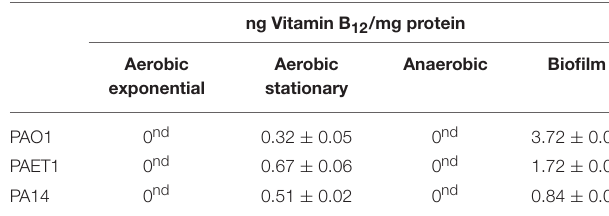
TABLE 3 | Quantification of vitamin B 12 levels by